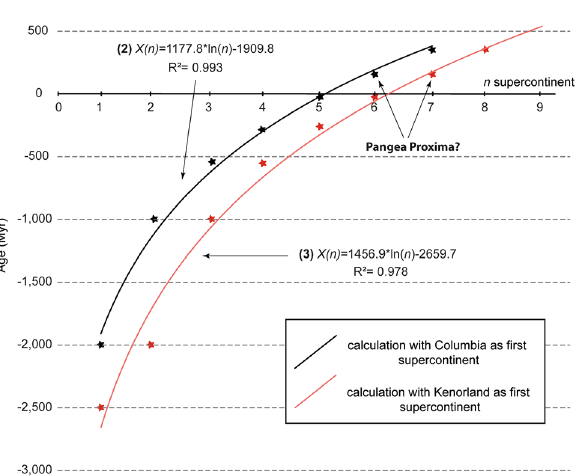
Figure 2. Plot of age of assembly versus n supercontinent cycles. It shows that the mathematical Eq. (1) results for n = (1;2;3;4;5;6;7;8) are consistent with two logarithmic regressions with a fairly good correlation factor. Positive ages represent dates in the future. The assembly results of the two regressions are portrayed in Table